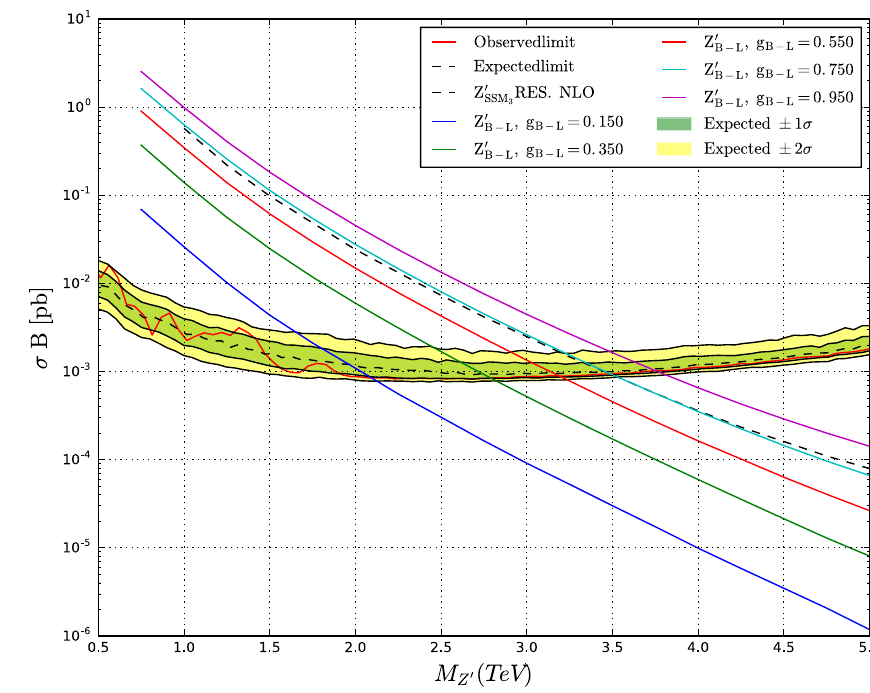
Fig. 7 Inclusive total cross section for pp → Z (cid:2) → (cid:13) ¯ (cid:13) at NLO+NLL in the U ( 1 ) B − L models for various values of g B − L as a function of the mass of the heavy resonance M Z